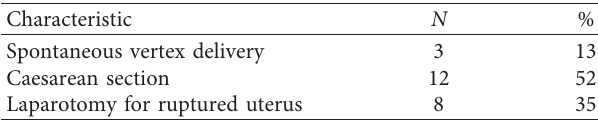
Table 3: Mode of delivery ( N � 23).